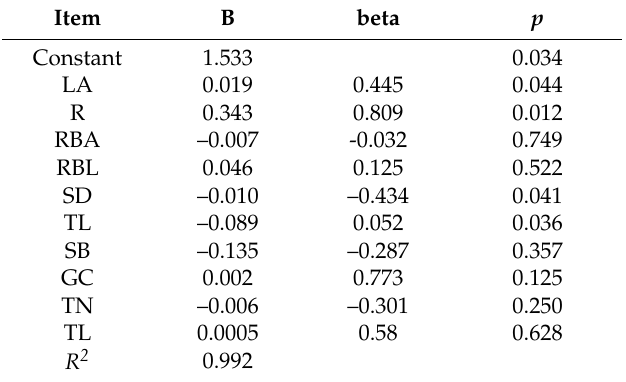
Table 4. Partial regression coefficients (B) and standardized regression coefficients (beta) from a multiple regression analysis of the leaf surface-trait effects on PM